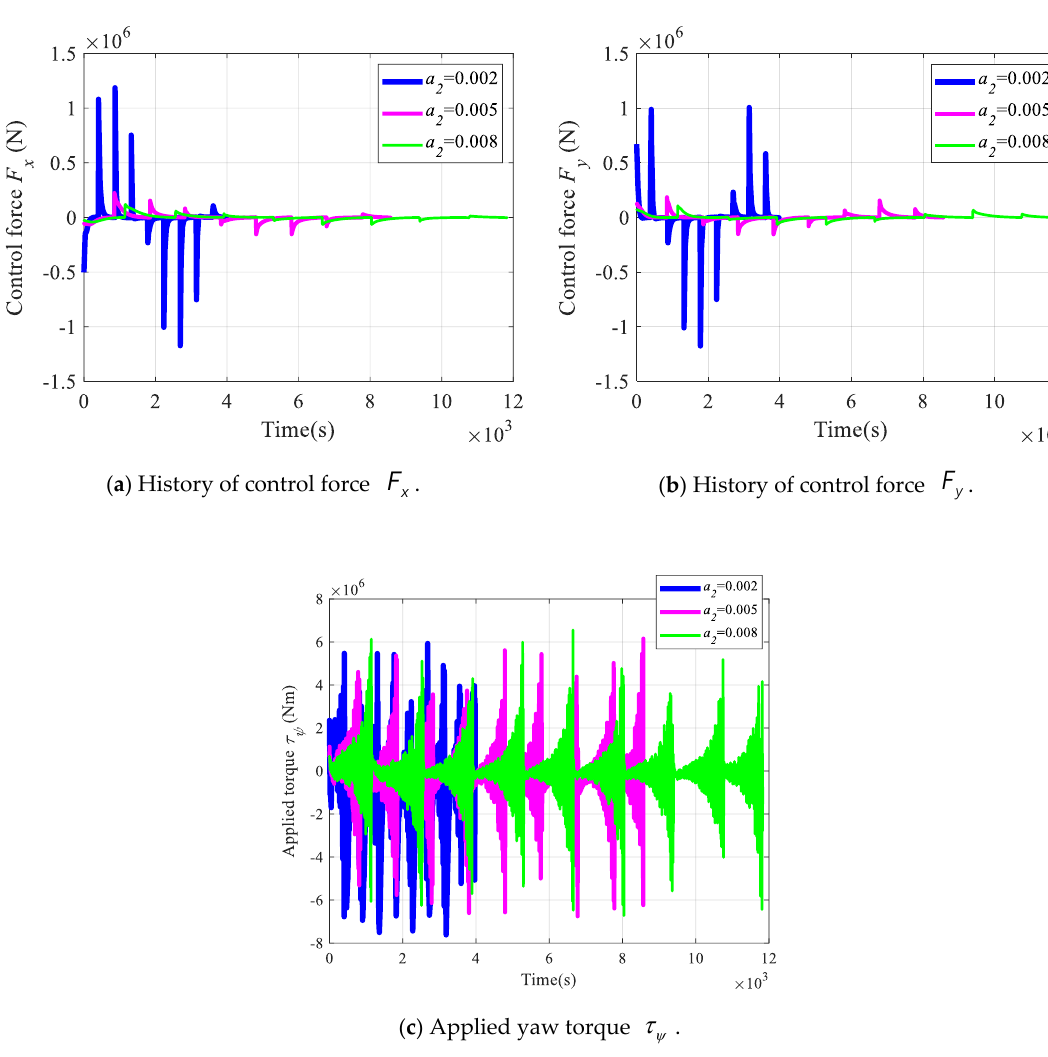
Figure 16. Control commands of controlled AUSV with respect to di ff erent control gains a 2 .